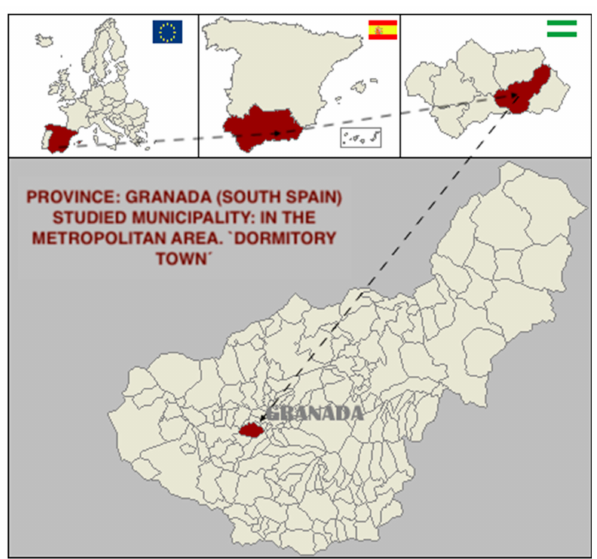
Figure 7. Territorial map of the municipality